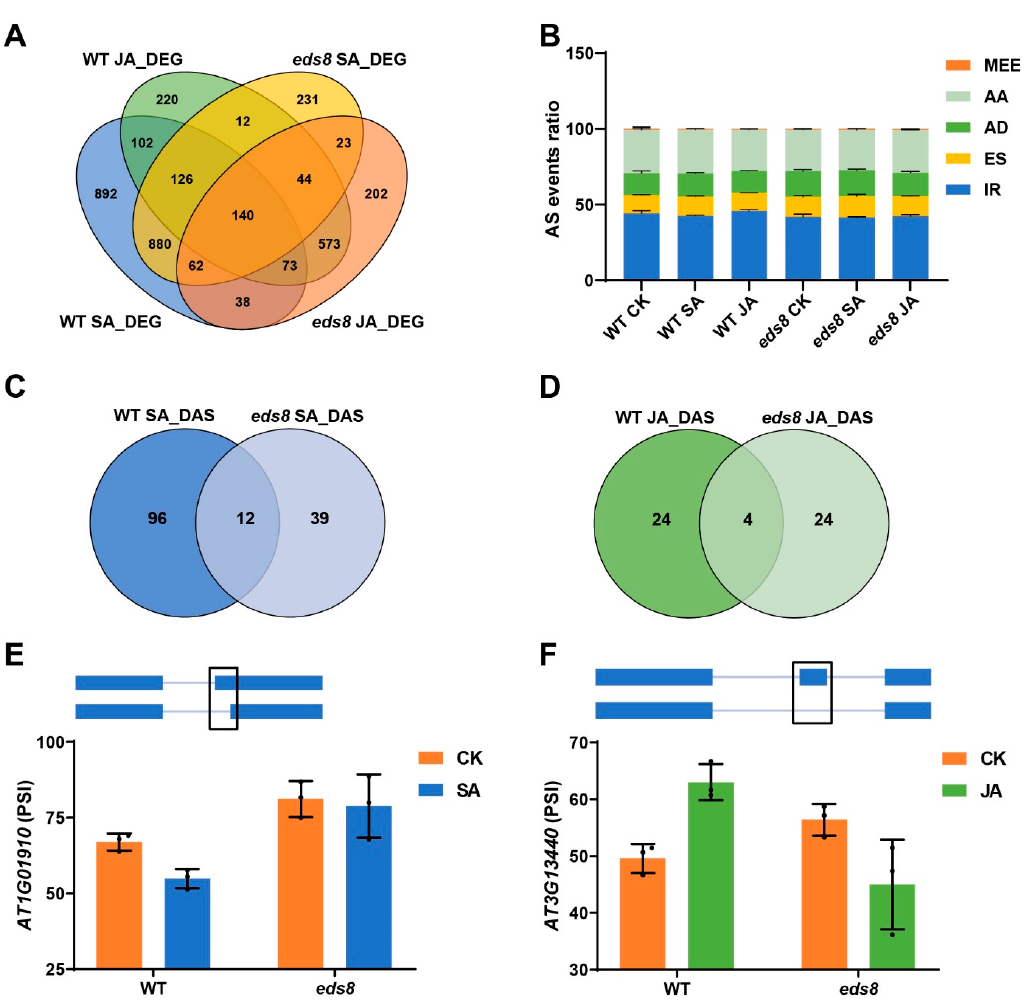
Figure 7. EDS8 influences SA and JA induced changes in gene expression and alternative splicing (AS). Twelve-day-old seedlings were treated with/without SA or JA, and samples were collected for full length RNA sequencing. ( A ) Venn diagrams of different expressing genes induced by SA and JA in WT and the eds8 mutant. ( B ) The different AS types for AS events in all samples. MEE, Mutually exclusive exons; AA, Alternative acceptor sites; AD: Alternative donor sites; ES, Exon skipping; IR, Intron retention. ( C ) Venn diagrams of different alternative splicing (DAS) genes in WT and eds8 mutant after SA treatment. ( D ) Venn diagrams of DAS genes in WT and eds8 mutant after JA treatment. ( E ) Representative EDS8 dependent and SA regulated DAS event (Event region NC003070.9:313419-313566 of At1g01910 ). ( F ) Representative EDS8 dependent and JA regulated DAS event (Event region NC003074.8:4378075-4378587 of At3g13440 ). Exons are represented as blue boxes, and introns as blue lines. PSI, percent spliced in.